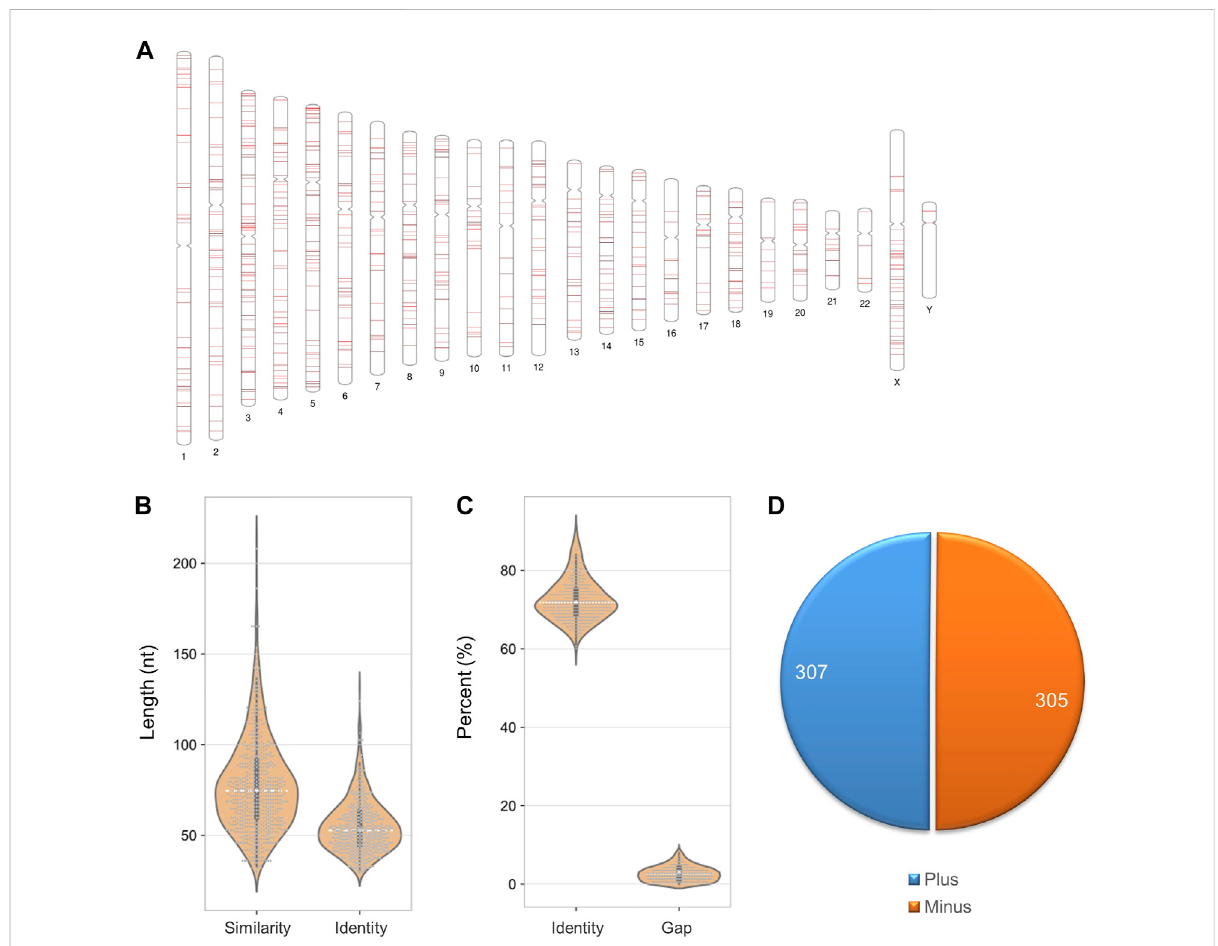
Sequence characteristics of similar loci between the SARS-CoV-2 and human genomes. (A) Distribution of similar sequences in the human chromosome. (B) Length of similar and consensus sequences. (C) The proportion of identity and gap. (D) Distribution of similar sequences in sense and antisense